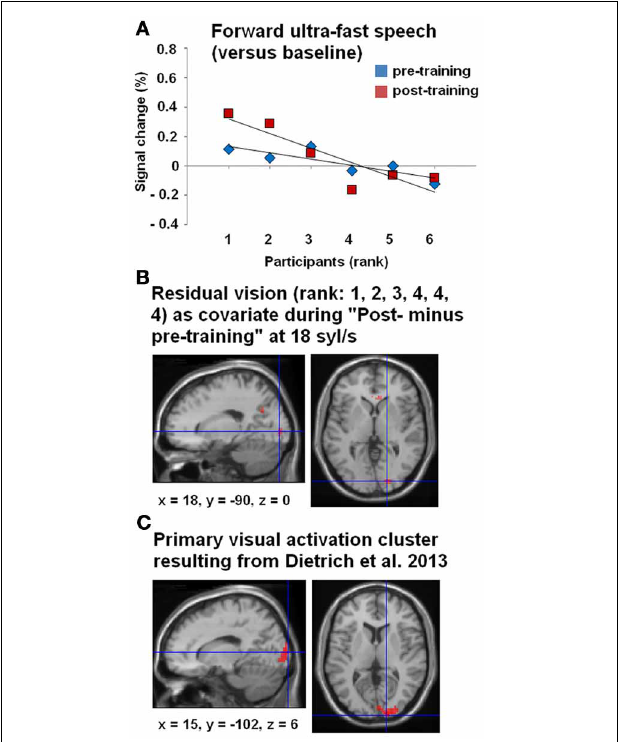
FIGURE 5 | (A) Correlations between BOLD responses during the forward ultra-fast (18syl/s) speech condition (vs. baseline) and the participants, arranged according to their residual vision (given as ranks 1–6: 1 = no residual vision and 6 = normally sighted within the right-hemispheric primary visual activation cluster, drawn from Dietrich et al. (2013) (see panel C ). Values of percent signal changes refer to the pre- (blue) and post-training (red) measurements of each subject. (B) Whole-brain covariance analysis (SPM T -contrast “post- minus pre-training,” forward ultra-fast speech condition) with residual vision as a non-linear covariate (rank 1, 2, 3, 4, 4, 4)—hypothesizing that primary visual activation will only change in subjects with no or very low residual vision. The location of this effect in visual cortex was similar to the activation cluster observed in Dietrich et al. (2013) (C)